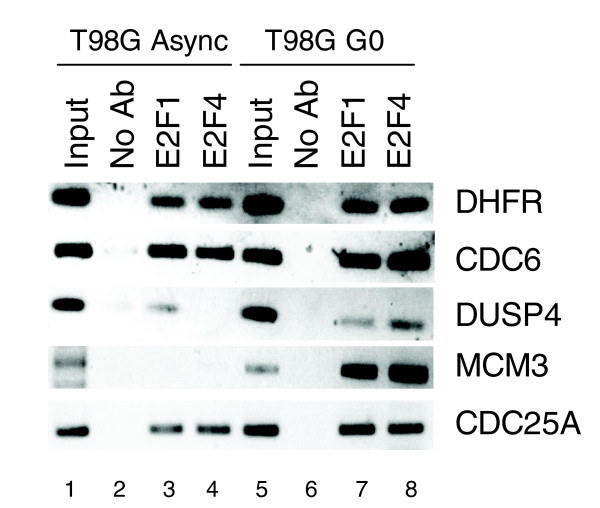
E2F1 and E2F4 occupancies in different promoter regions predicted by differential binding site search. A chromatin immunoprecipitation experiment was performed as described in the text. Mock experiments were done using no antibodies (No Ab), which served as a negative control for the experiment. Input lane represents polymerase chain reactions using 0.1% of total input chromatin. E2F, elongation factor-2.